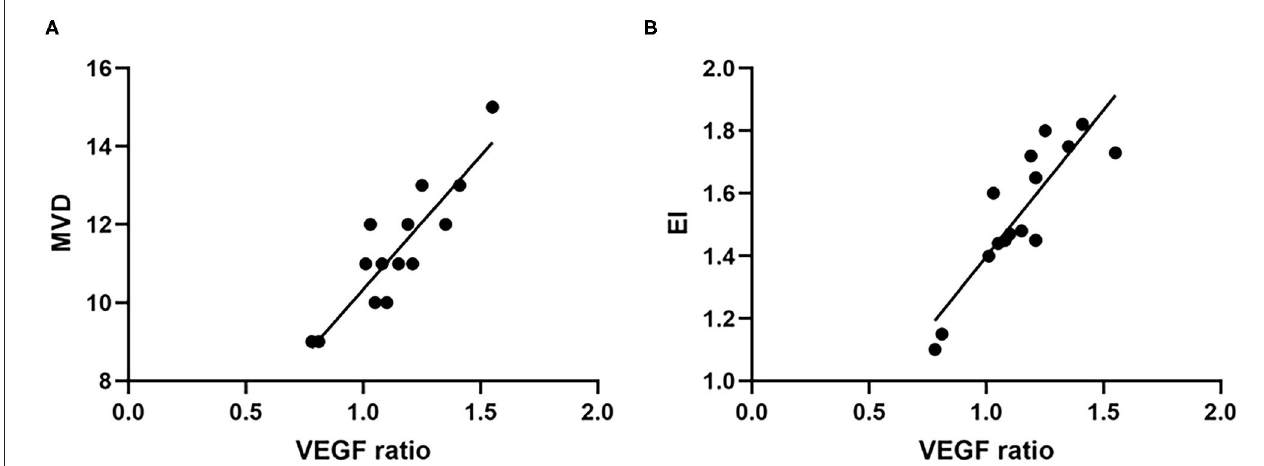
FIGURE 4 | The expression level of VEGF was positively correlated with MVD (A) and EI (B) . VEGF, vascular endothelial growth factor; MVD, microvessel density; EI, edema